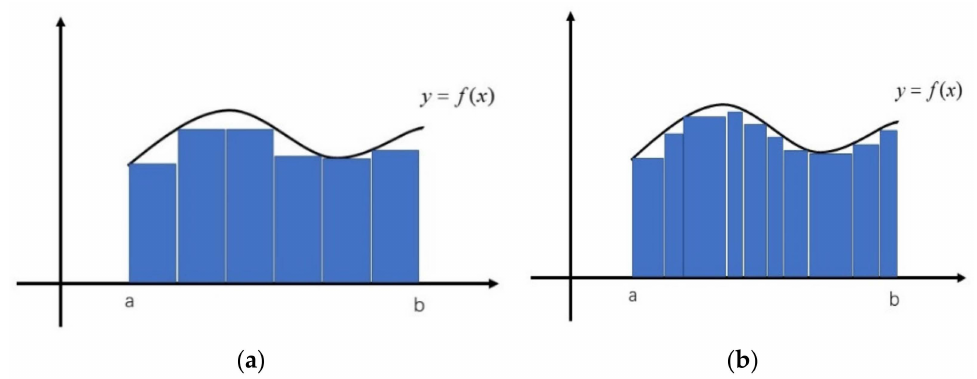
Figure 1. Two methods of segmentation when solving numerical integrals: ( a ) equidistant division and ( b ) equidistant